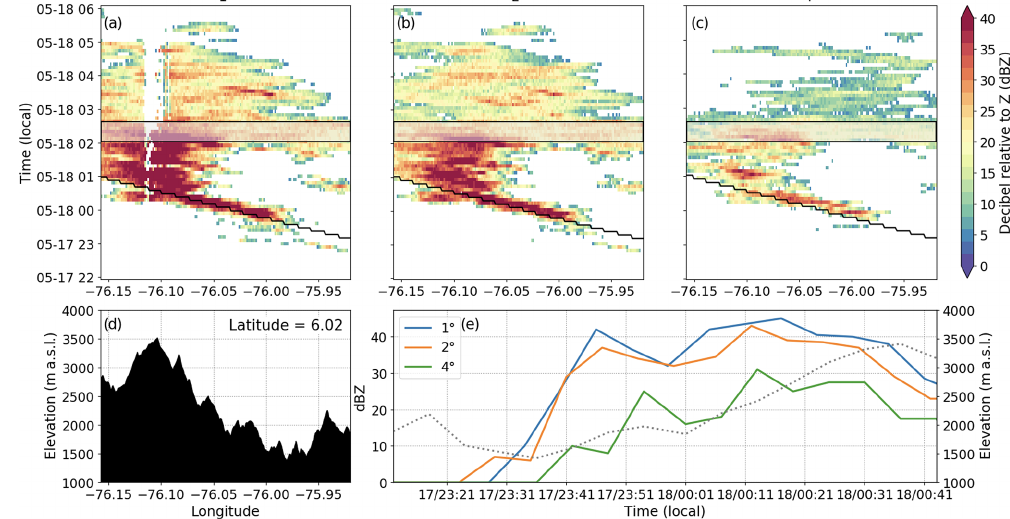
Figure 15. (a–c) Hovmöller diagrams (longitude–time cross section) at 6 ◦ N for different radar scanning tilts at 1, 2, and 4 ◦ , respectively. (d) Topography of the region at 6 ◦ N. (e) Continuous lines show the temporal evolution of Z h along the black line in (a–c) , and the dashed line shows the corresponding terrain elevation below the precipitating cloud.